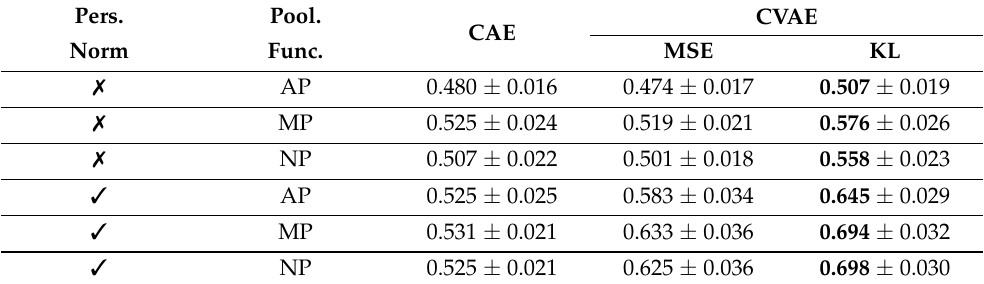
Table 15. ROC AUC scores for the discrimination between sessions that correspond to stable, or anomalous, condition, for both CVAE and CAE global models, depending on the normalization protocol and pooling function used. Pers. Pool. CVAE CAE Norm Func. MSE